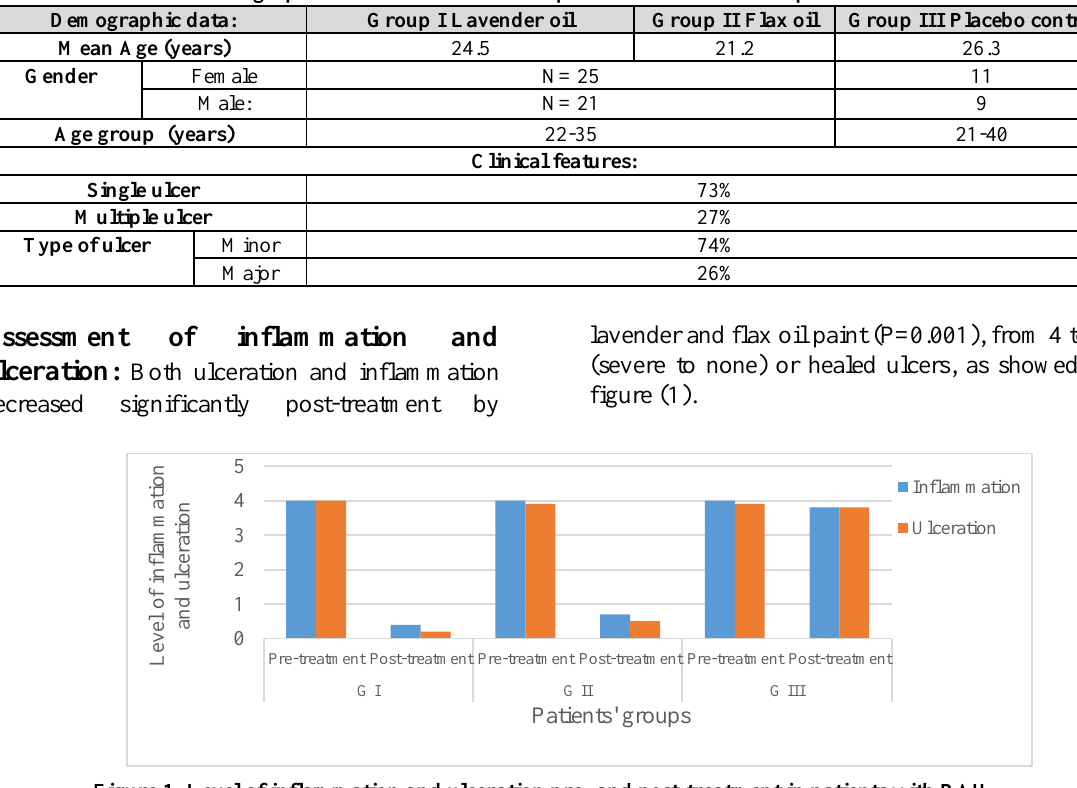
Table 2: Plasma values of antioxidant parameters of enrolled patients’ groups.